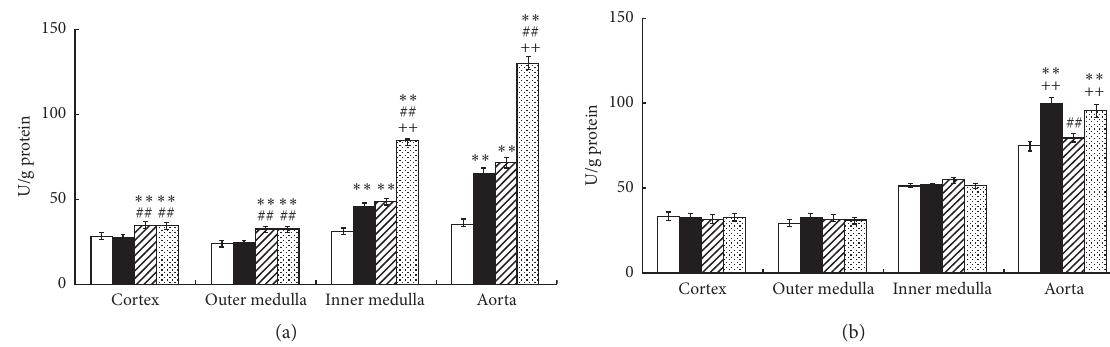
Figure 4: Effects of Ex and tempol on total SOD activity in SHR and WKY. The total SOD activity in the renal cortex, outer medulla, inner medulla, and aorta of SHR (a) and WKY (b) was compared among the control group (open bars), Ex group (closed bars), Tmp group (hatched bars), and Ex+Tmp group (checked bars) ( n � 10 in each group). ∗ P < 0 . 05 vs. the control group. ∗∗ P < 0 . 01 vs. the control group. ## P < 0 . 01 vs. the Ex group. ++ P < 0 . 01 vs. the Tmp group.